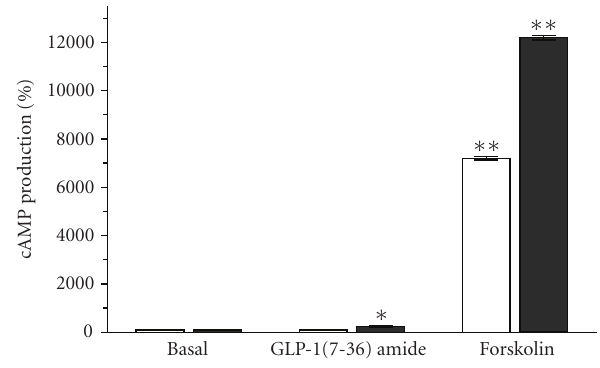
Figure 7: E ff ect of GLP-1(7-36)amide and forskolin on the produc- tion of cAMP from CHO and Rin m5F cells. Wild type CHO cells (empty bar); Rin m5F cells (filled bar). 100 % = 46.7 fmol/mg and 40.9 fmol/mg for CHO cells and Rin m5F, respectively (basal value, no ligand added). Each bar with the indicated standard deviation represents the mean value of three independent experiments done in duplicate. ANOVA: F(5,12) = 31250; P < .0001. Tukey-Kramer multiple comparison test was used to reveal significant di ff erences between groups of interest. See Results for the details.